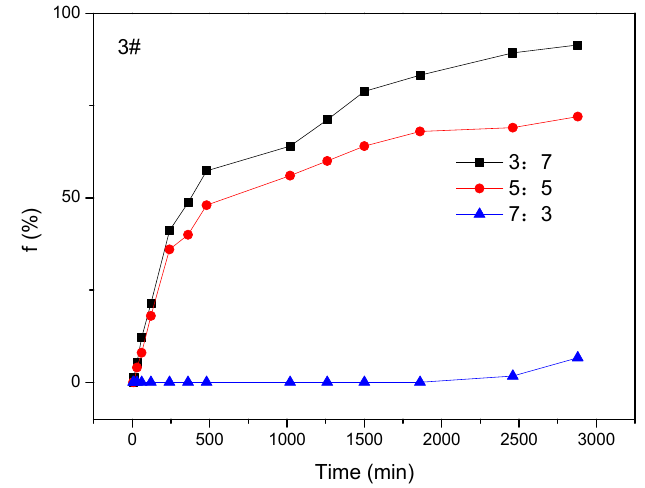
Figure 4. The water separation rate of different oil–water ratios over time.